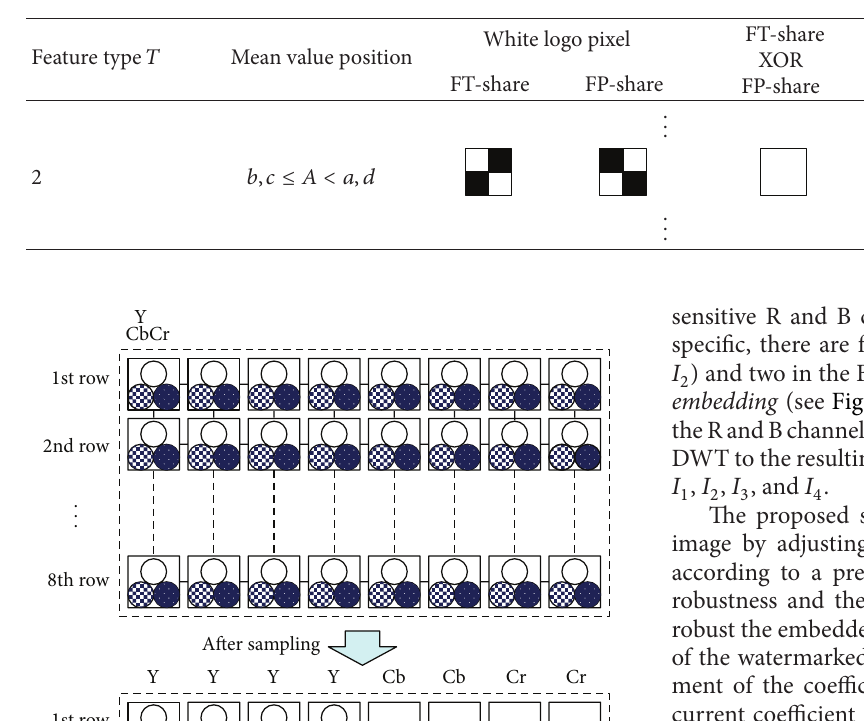
Table 2: Partial table of Table 1.